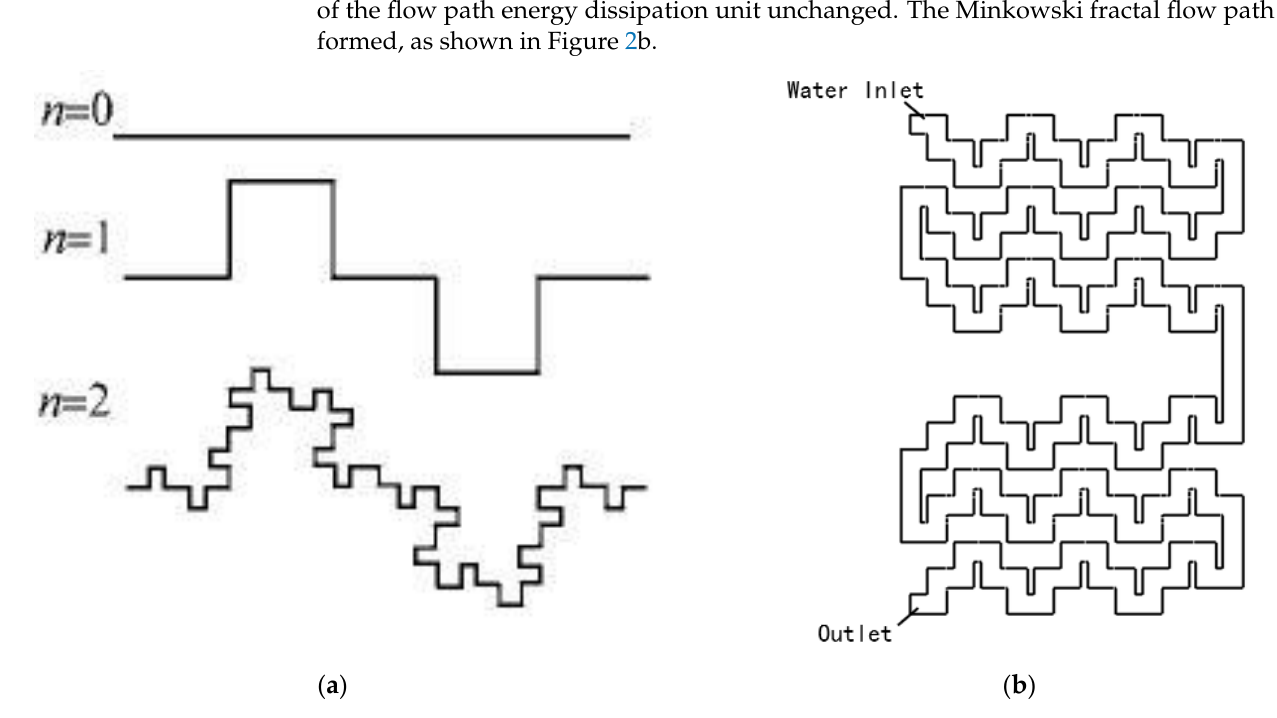
Figure 2. Minkowski fractal flow path generation schematic. ( a ) Minkowski curve; ( b ) Minkowski flow path design diagram.